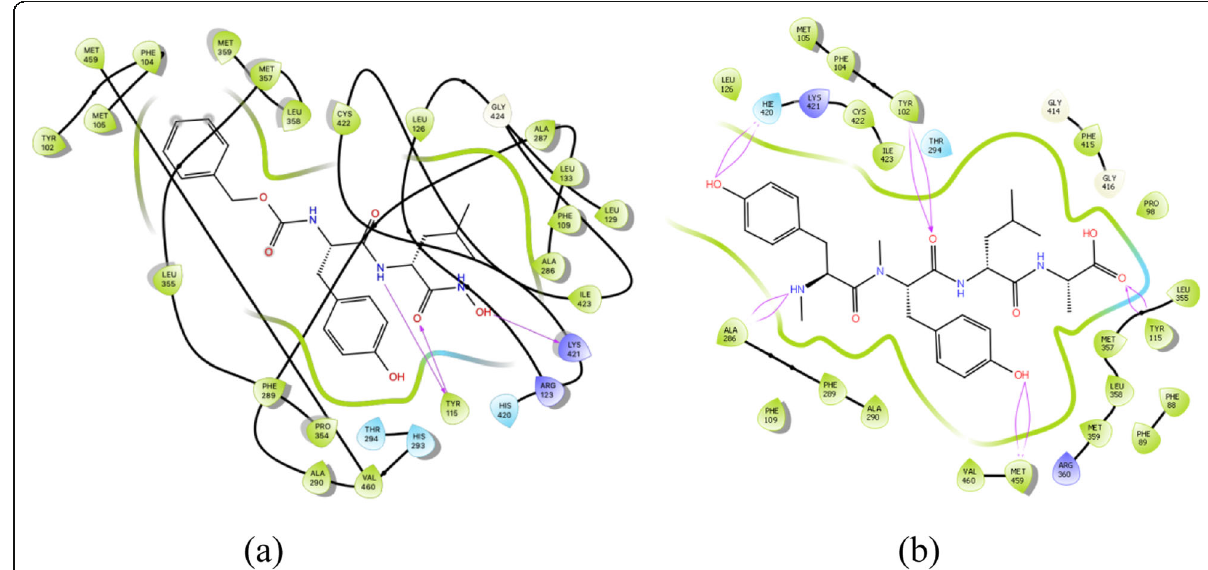
Fig. 6 a Target-ligand interaction diagram of CYP51-46173719. b Target-ligand interaction diagram of